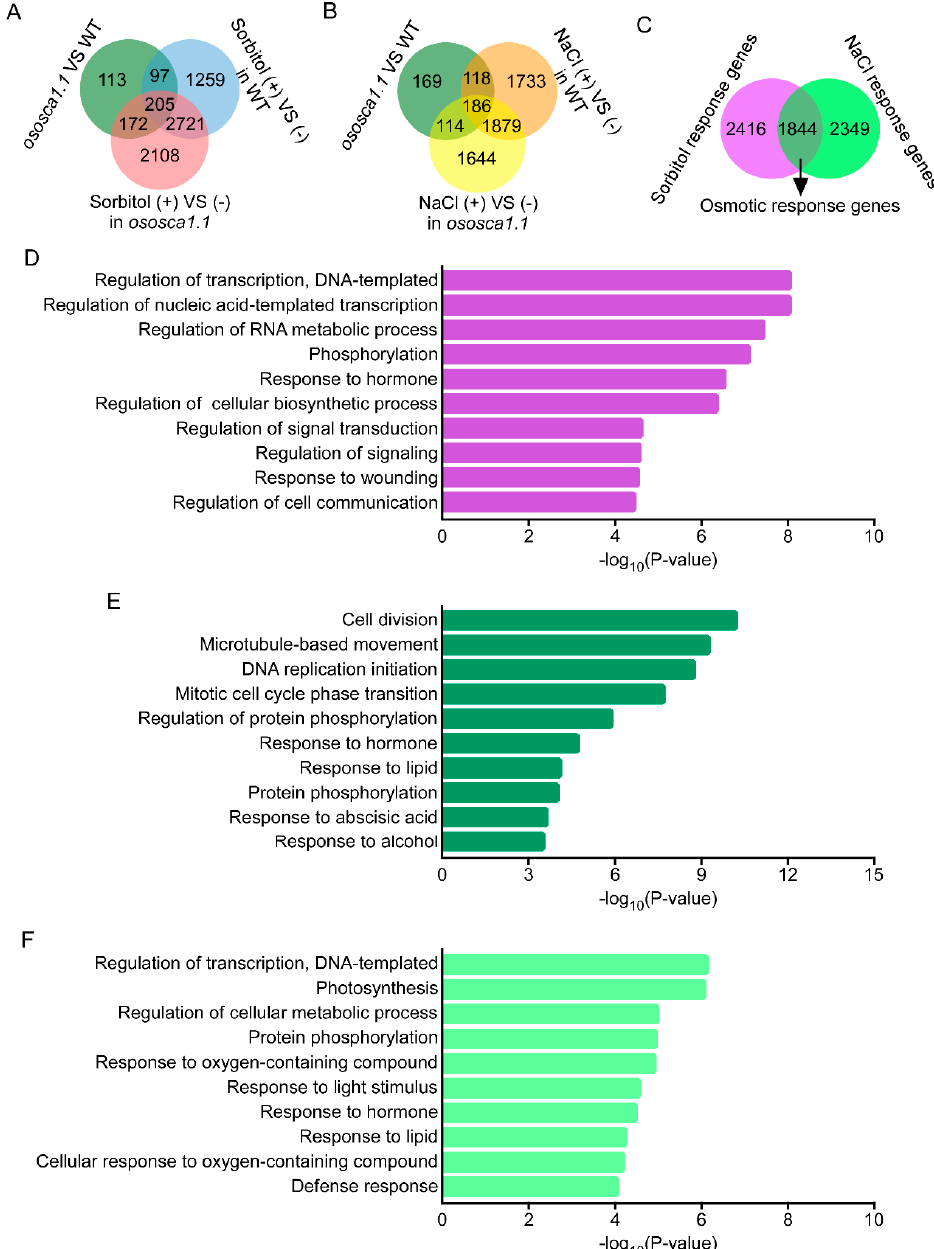
Figure 3. The enrichment analysis in the biological process category of Gene Ontology (GO) with OsOSCA1.1-regulated genes in 30-day-old rice shoots in response to hyperosmolality and salt stress treatment. ( A , B ) Venn diagram showing unique and shared differentially expressed genes (DEGs) between ZH11 and ososca1.1 plants treated with ( A ) 250 mM of sorbitol and ( B ) 125 mM of NaCl for 24 h. ( C ) Venn diagram showing OsOSCA1.1-regulated genes in response to hyperosmolality (250 mM of sorbitol) and salt stress (125 mM of NaCl) treatment. ( D – F ) Enrichment analysis in biological process category of GO, with OsOSCA1.1-regulated sorbitol response genes ( D ), osmotic stress response genes ( E ), and NaCl response genes ( F ). GO term information for DEGs was extracted from BLAST results against the SWISS-PROT database and the top 10 terms are displayed.